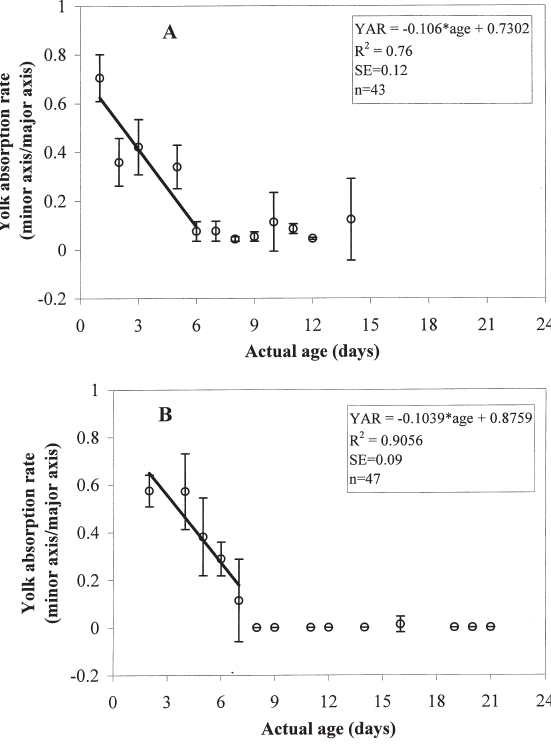
F IG . 4. – Relationship between yolk absorption rate and the actual age of the larvae of Patagonotothen tessellata . Yolk ratio is